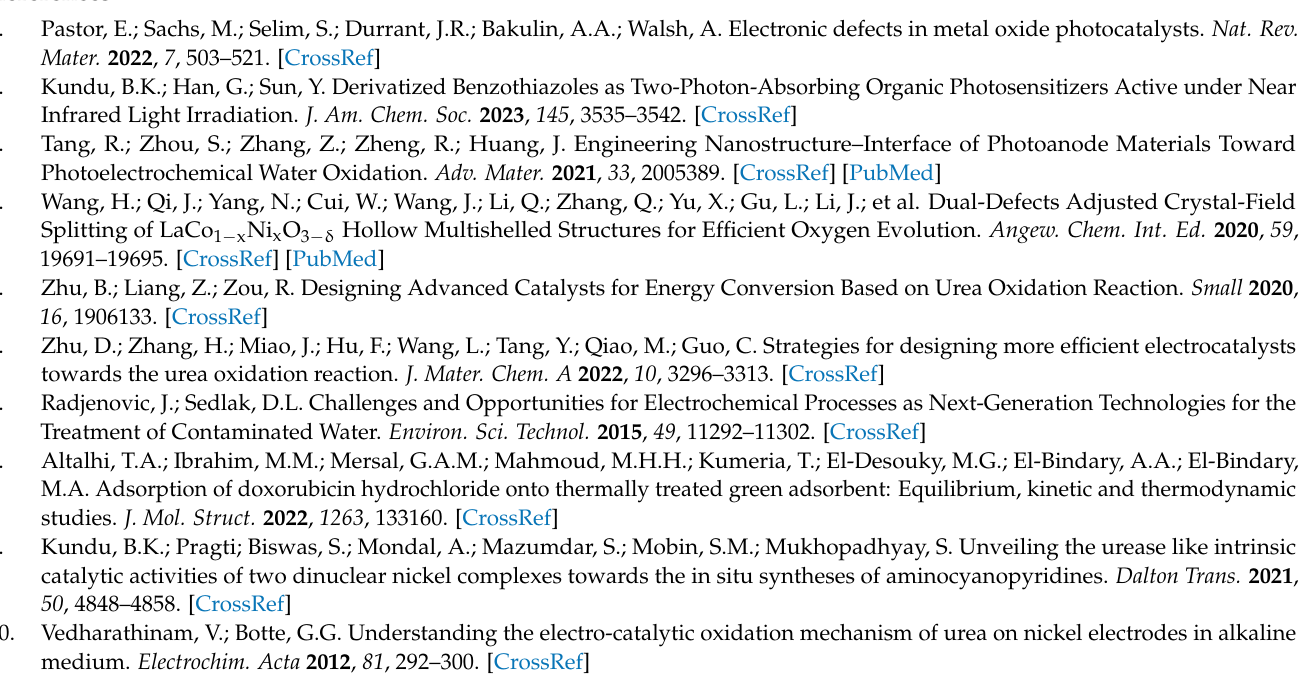
Figure S16: The relationship curves between the capacitance current and the scan rate of TiO 2 -based Table S1: PEIS fitting parameters of TiO 2 , Ni(OH) 2 @TiO 2 and T-Ni(OH) 2 @TiO 2